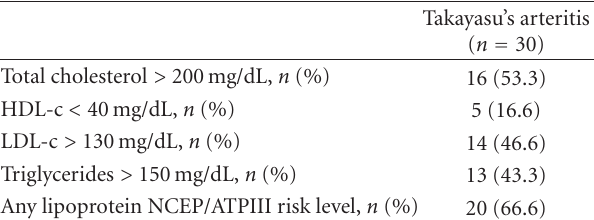
Table 2: Risk levels of Takayasu’s arteritis patients according to NCEP/ATPIII. HDL-c = high-density lipoprotein cholesterol; LDL- c = low-density lipoprotein